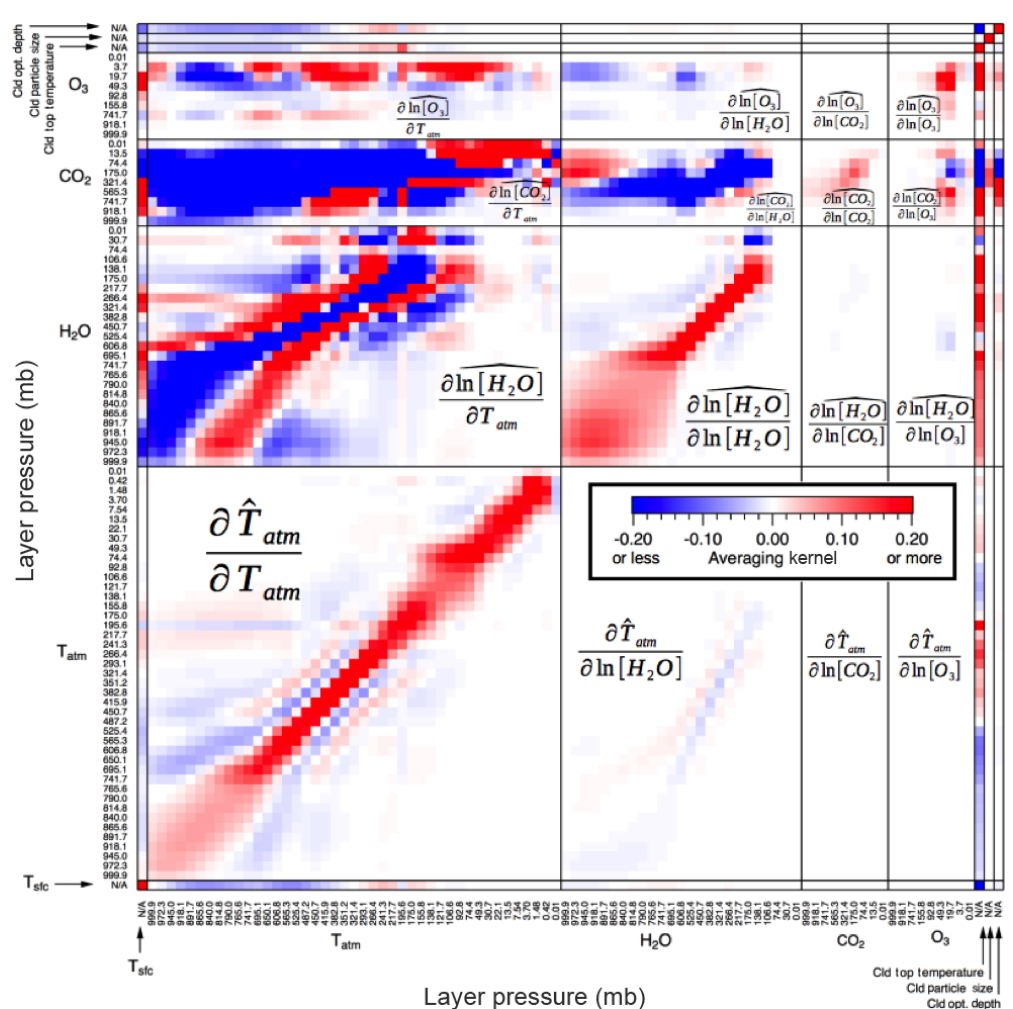
Figure 4. Sample averaging kernel from a simultaneous retrieval. A row of the averaging kernel matrix is a measure of the sensitivity of the retrieved value to changes in the true value of itself and other parameters, shown in the columns, assuming the retrieval is in a near-linear regime. A column indicates the sensitivity of the retrieved state vector to a change in the true value of a single retrieval parameter. The color scale has been limited to better show the weaker